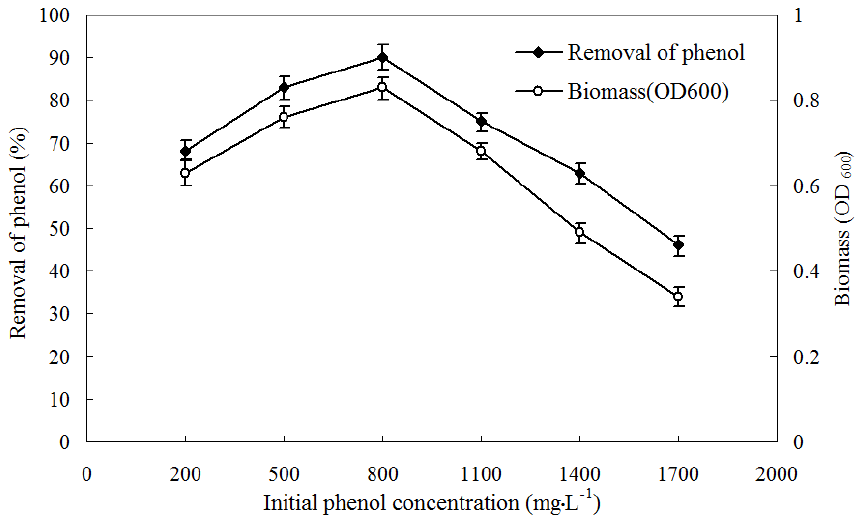
Figure 3. Profile of bacterial cell growth and phenol degradation at various initial concentrations of of phenol.